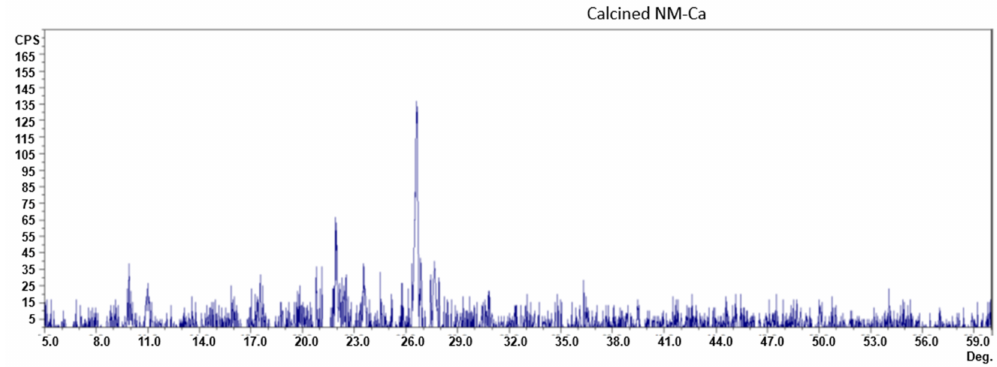
Figure 4. The XRD pattern of calcined